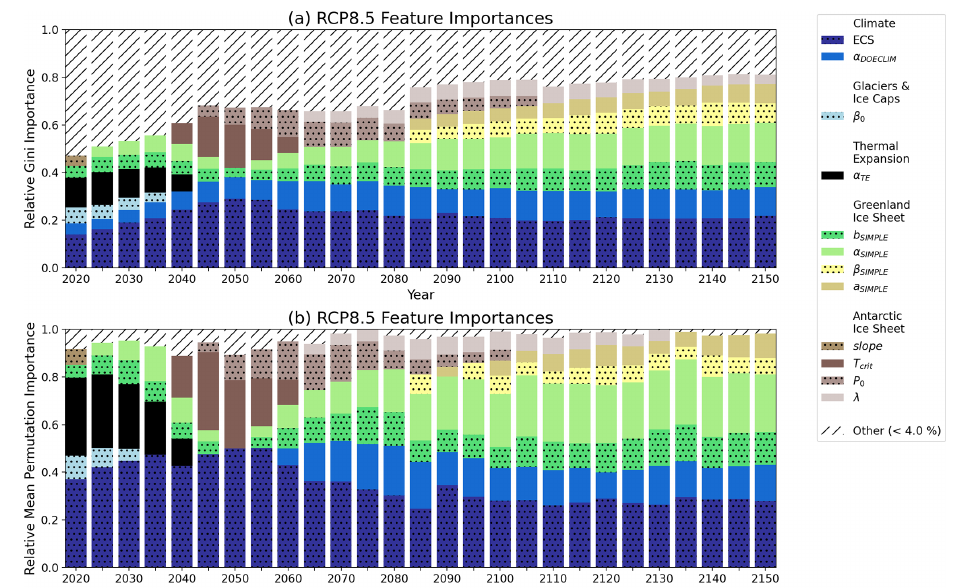
Figure A6. Relative feature importances of the BRICK model parameters calculated based on the fitted random forests using different feature importance measures. Shown are the importances of the BRICK model parameters using (a) the RCP8.5 radiative forcing scenario with Gini importances and (b) the RCP8.5 forcing scenario with permutation importances. All model parameters with an importance less than 4% were grouped into an “other” category, which is shown with hatch marks to denote its difference from the parameters. Stippling was added to alternating parameters in the legend to aid in telling the difference between similar